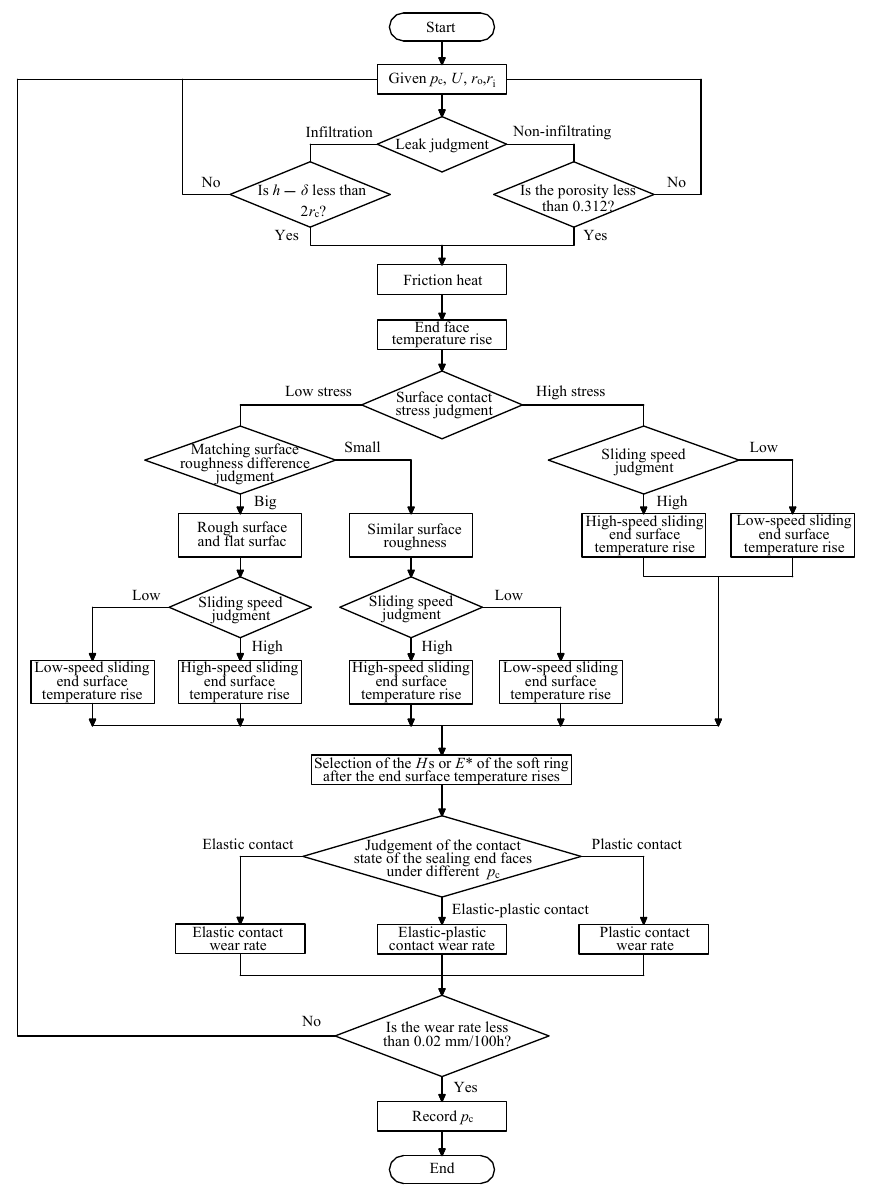
Figure 3. Solution process of the face contact pressure range.